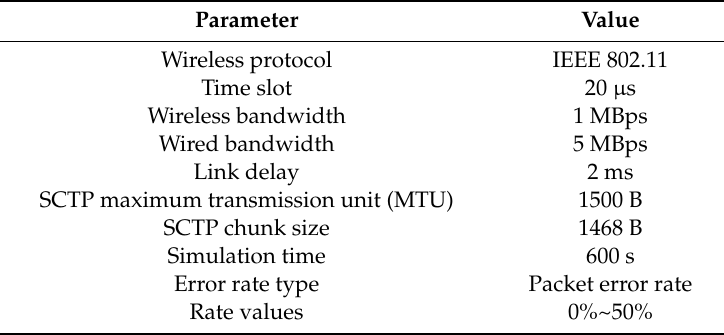
Figure 1. Simulation scene topology. Table 1. Parameters Settings. Table 1. Parameters Settings.